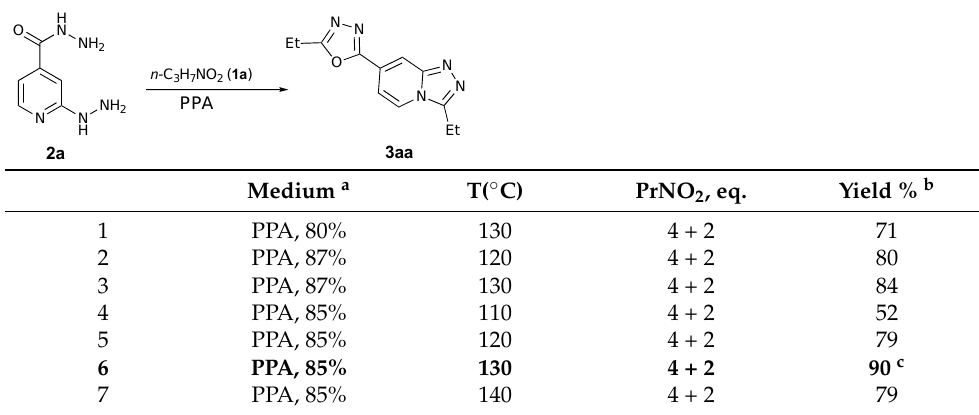
Table 1. Optimization of the reaction conditions for a one-pot double-annulation toward a chimeric product 3aa